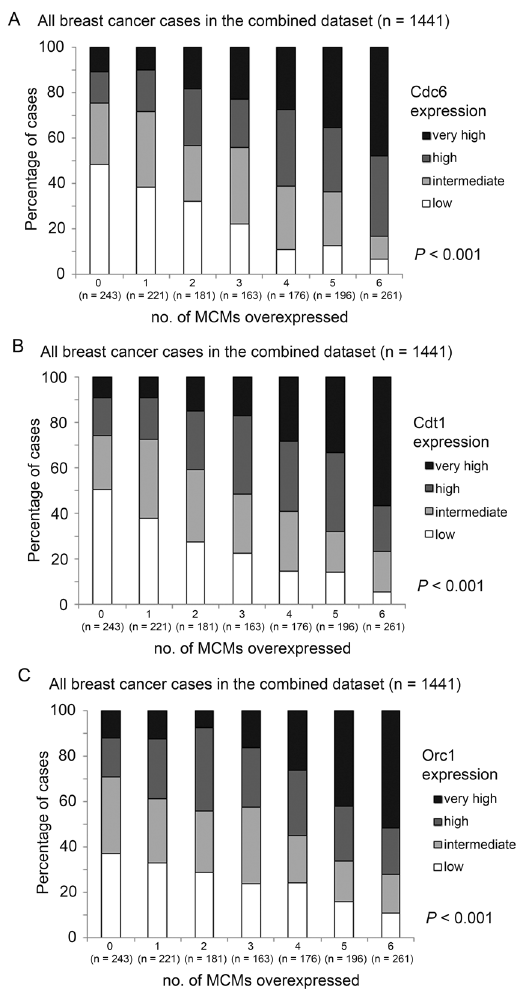
Figure 1. The expression levels of Cdc6, Cdt1 and Orc1 in breast cancer patients expressing various levels of MCM genes. Histograms showing percentage of specimens that expressed different levels of ( A ) Cdc6, ( B ) Cdt1 and ( C ) Orc1 in six groups of specimens stratified by the number of MCM2-7 genes they